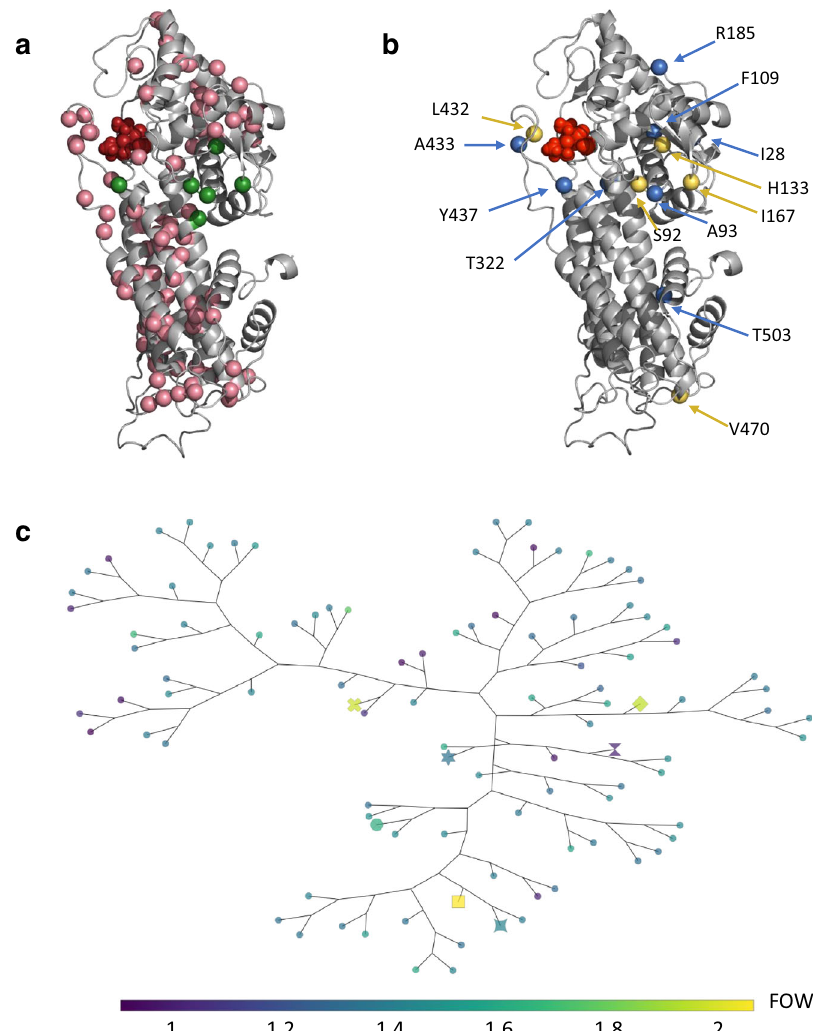
Fig. 3 Designed and enriched mutation positions. Positions of interest are highlighted on a homology model generated for StlA using RosettaCM. Active site residues are highlighted in red. a Positions targeted for combinatorial mutagenesis during library construction. Any positions mutated in the library templates (see Methods) are highlighted in green, and additional mutations targeted during combinatorial mutagenesis are shown in pink. b Positions mutated in top hits. Positions mutated in the fi nal SYNB1934 PAL variant are highlighted in yellow, and those mutated in other top hits (indicated with special markers in c , further detail in Supplement) are shown in blue. c A phylogenetic tree was generated by computing the distance between all the sequences using the Blosum62 substitution matrix 57 and constructing the tree by neighbor-joining in Biopython 58,59 . Colors indicate activity level normalized to wild-type (FOWT). Markers: square = S92G_H133F_A433S_V470A, diamond =